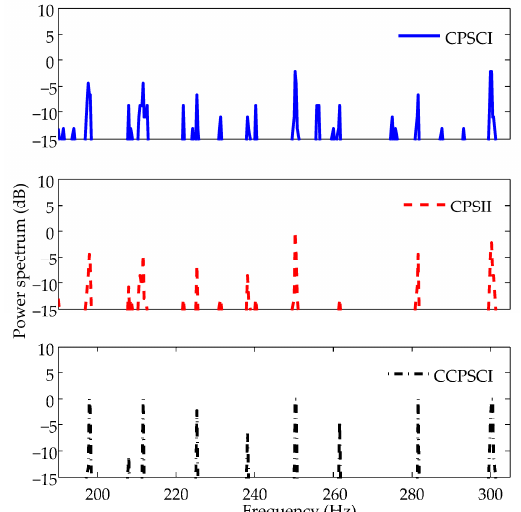
Figure 11. Averages of power spectra estimated by CPSCI, CPSII, and CCPSCI in experimental data processing. It can be seen from these results that CPSII and CCPSCI can improve the SNRs of discrete spectra much better than CPSCI. However, the discrete spectrum at 262 Hz cannot be detected by CPSII. Compared with CPSCI and CPSII, CCPSCI can provide an additional 2~6 dB integration gain.